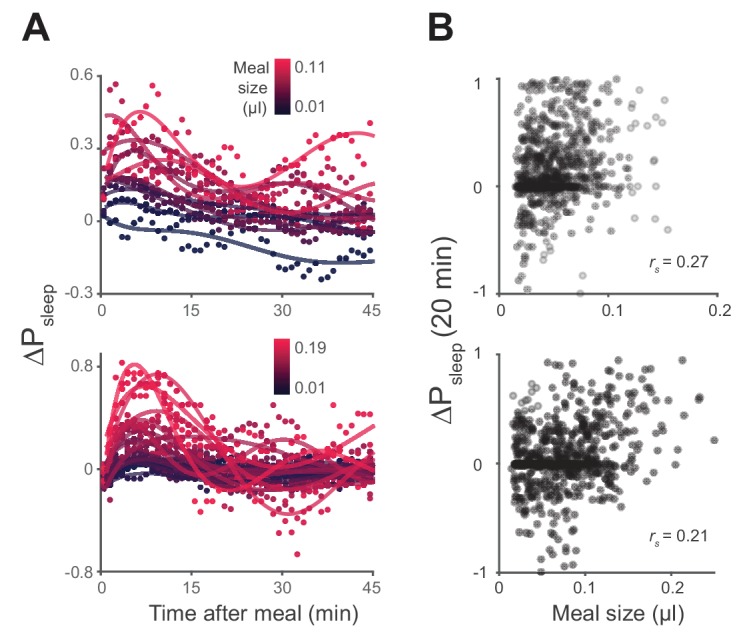
Sleep probability and ΔPsleep response to meal size.(A) Time-course of ΔPsleep for meals grouped by volume (0.01 µl meal groupings, circles represent 1 min binned averages, lines represent spline fit). (B) Correlation between meal size and ΔPsleep in 20 min after feeding events for Canton-S and w1118 (Spearman rank-order correlation: p=9.0 × 10−14, Canton-S; p=4.1 × 10−8, w1118).